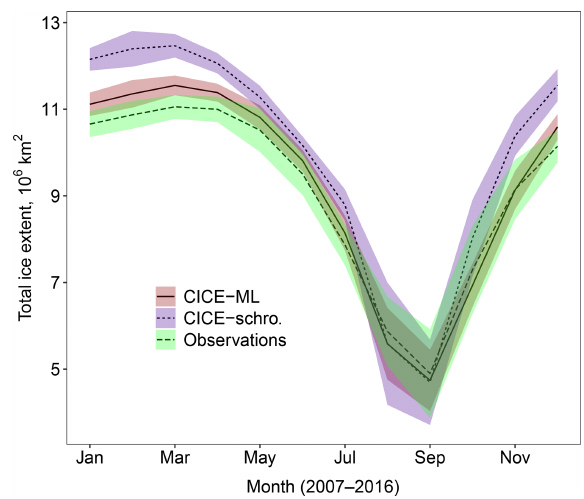
Figure 2. Comparison of the 2007–2016 mean cycle for the to- tal Arctic sea ice extent simulated in the coupled CICE–prognostic mixed-layer reference set-up (marked CICE–ML, red ribbon, solid) with the results from the standard optimised CPOM CICE model (Schröder et al., 2019, marked CICE-schro, blue ribbon, small dashes) and observed sea ice extent derived from Nimbus-7 SMMR and DMSP SSM/I–SSMIS satellites using Bootstrap algorithm ver- sion 3 (Comiso, 1999, marked Observations, green ribbon, large dashes). The ribbon shows, in each case, the region spanned by the mean value plus or minus 2 times the standard deviation for each simulation. This gives a measure of the interannual variability over the 10-year period. Results show the new model performs either comparably to or better than the previous optimum set-up through- out the year. In addition, the mean CICE–ML sea ice extent falls within the interannual variability of the observations between June and December, i.e. most of the melting season, suggesting this ref- erence state is suitable for studies focusing on this